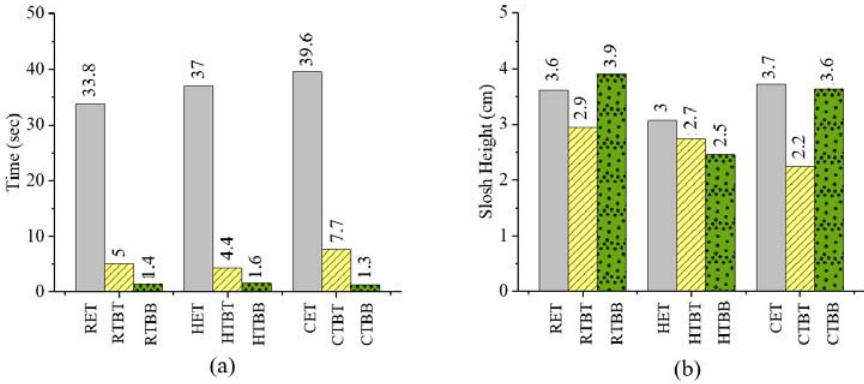
Figure 15. Average slosh impact ( a ) time and ( b ) height comparisons using different tank setups.